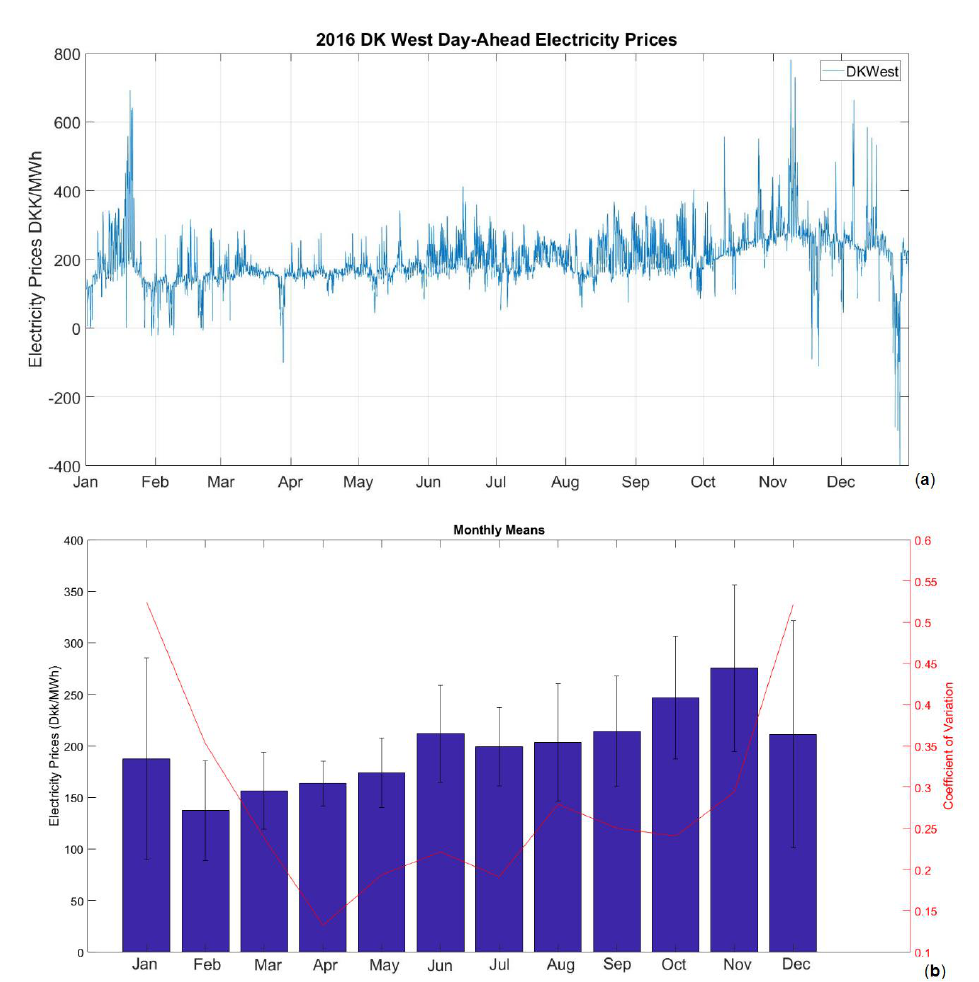
Figure 2. DK west day ahead electricity prices ( a ), monthly mean, coefficient of variation, and standard deviation ( b ).